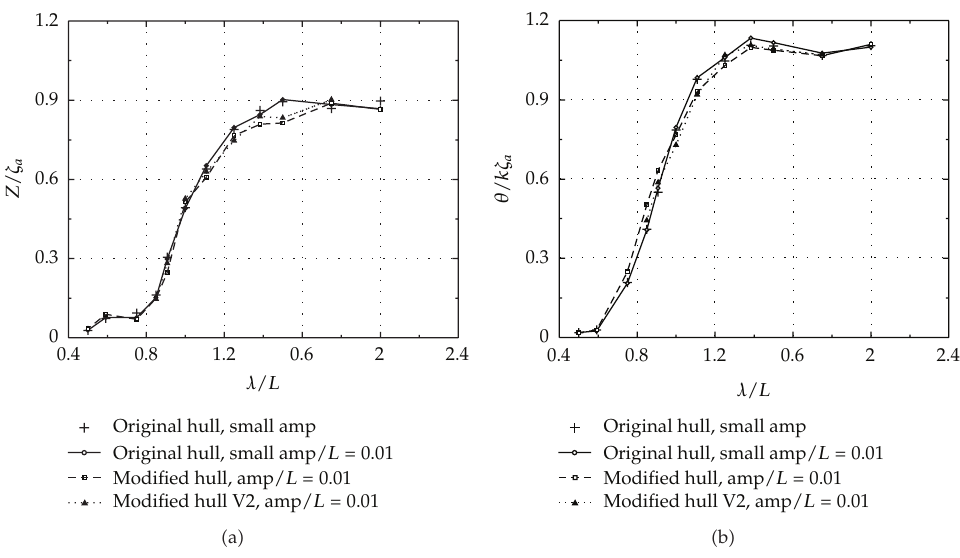
Figure 13: Heave and pitch amplitude of three di ff erent Wigley hulls; F n (cid:7) 0 . 2, Amp /L (cid:7) 0 . 01.